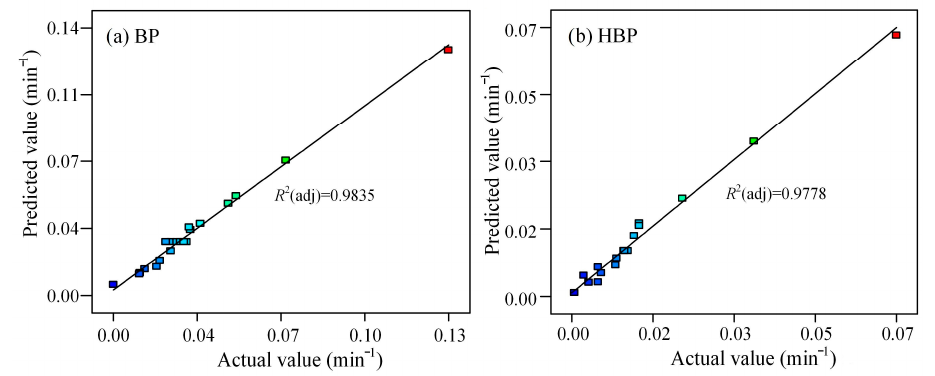
Figure 5. Actual values versus predicted values obtained from the estimated model. (Colors represent